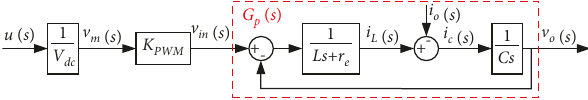
Figure 2: Equivalent block diagram of the single-phase inverter.